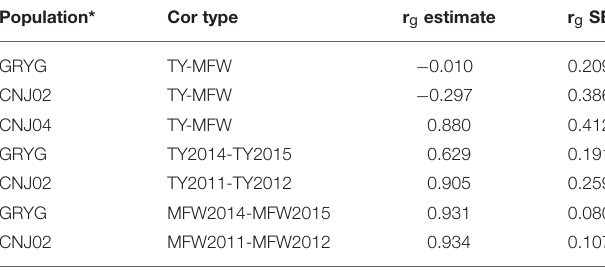
TABLE 2 | Genetic correlation between years within traits, among traits (rg estimate), and their standard errors (h 2 g SE) in three biparental populations (CNJ02, N = 148; CNJ04, N = 67; GRYG, N =